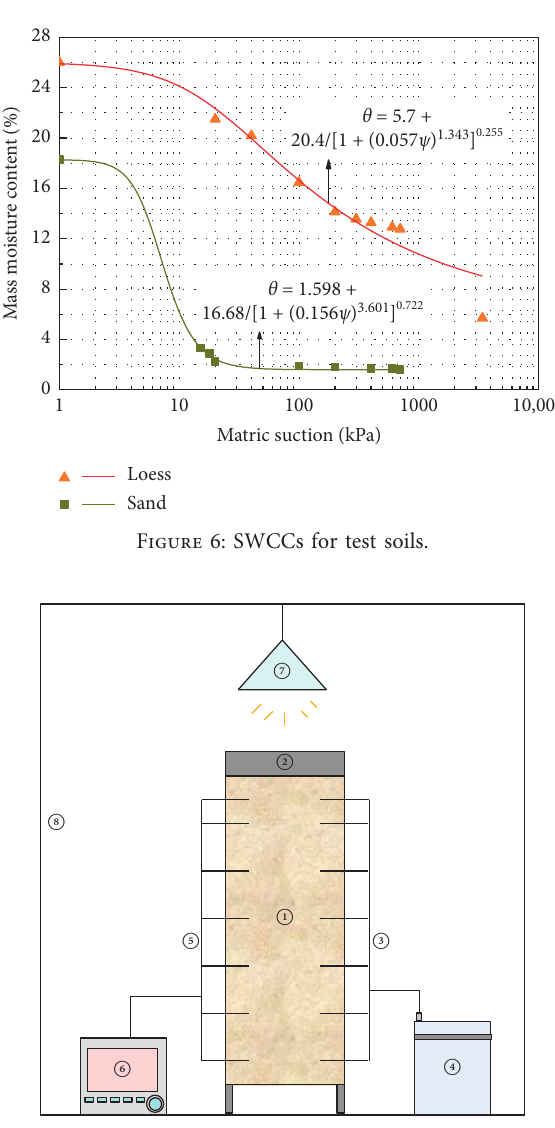
Figure 7: Test apparatus for water vapor migration.